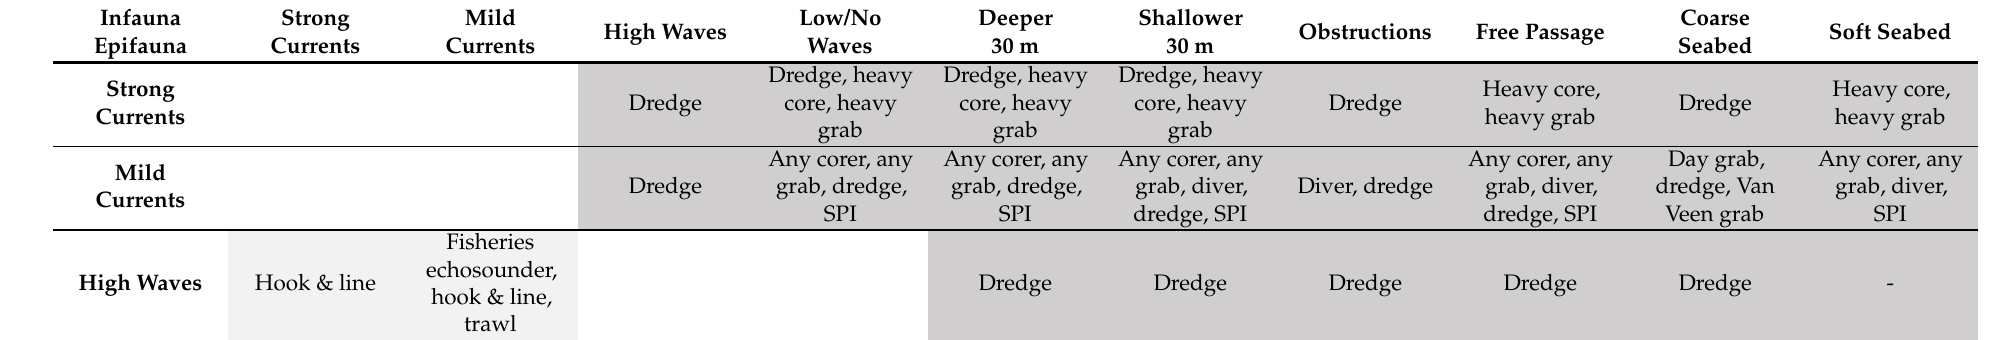
Table 6. Technology recommendations for surveying epibenthic and demersal organisms (light grey lower matrix) and infauna organisms (dark grey upper matrix) at wave and tidal energy